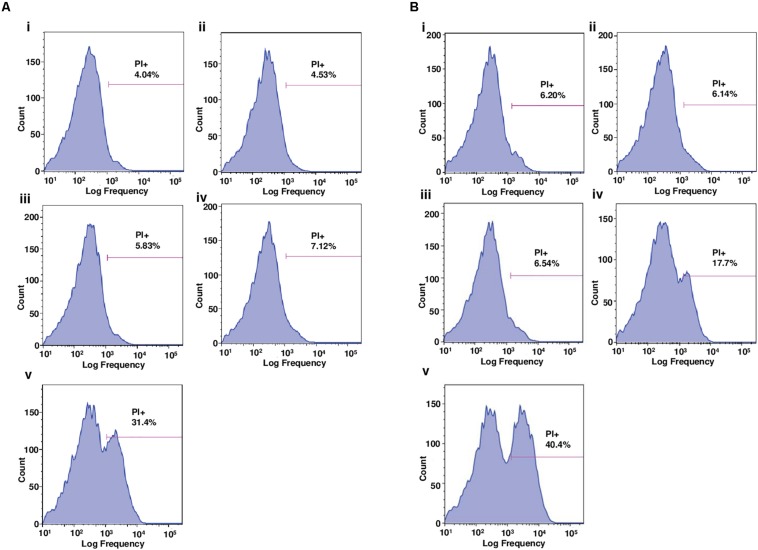
(A) Flow cytometric analysis of the proportion of M. tuberculosis H37Rv cells positively stained by the membrane-impermeable dye, propidium iodide (PI), following 3 h treatment with (i) media, (ii) rifampicin, (iii) BM 1, (iv) BM 2, and (v) BM 3. Drug treatments were performed at 4 × MIC concentration (64 mg/L). BM1 treated cells demonstrated negligible uptake of PI similar to the negative controls (media and rifampicin). BM 2 induced a slight uptake of PI and BM 3 induced significant uptake suggestive of membrane permeabilizing mechanisms of action. (B) Flow cytometric analysis of the proportion of M. tuberculosis CSU87 cells positively stained by PI, following 3 h treatment with (i) media, (ii) moxifloxacin, (iii) BM 1, (iv) BM 2, and (v) BM 3. Drug treatments were performed at 4 × MIC (32 mg/L) concentration. As expected BM1 treatment resulted in negligible uptake of PI similar to the negative controls (media and moxifloxacin). BM 2 and BM 3 both induced significant uptake of PI suggestive of membrane permeabilizing mechanisms of action. Data are representative from one of three independent runs.